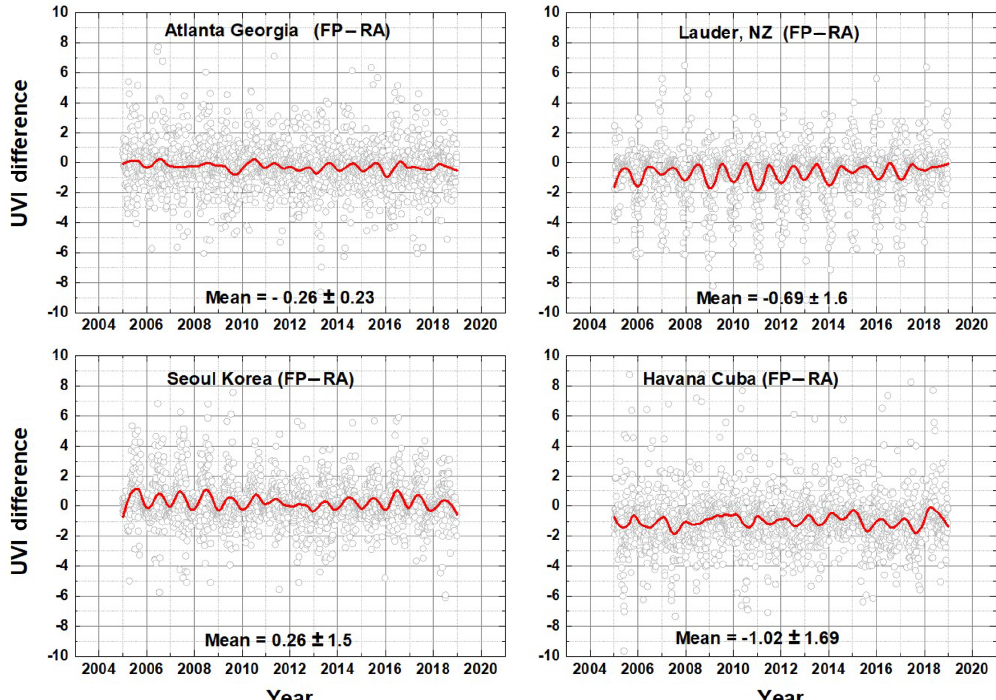
Figure 2. A comparison of the OMI erythemal irradiance algorithm (RA) with the fast polynomial algorithm (FP) for four sites. The red lines are approximately a 1-year Loess(0.1) fit to the